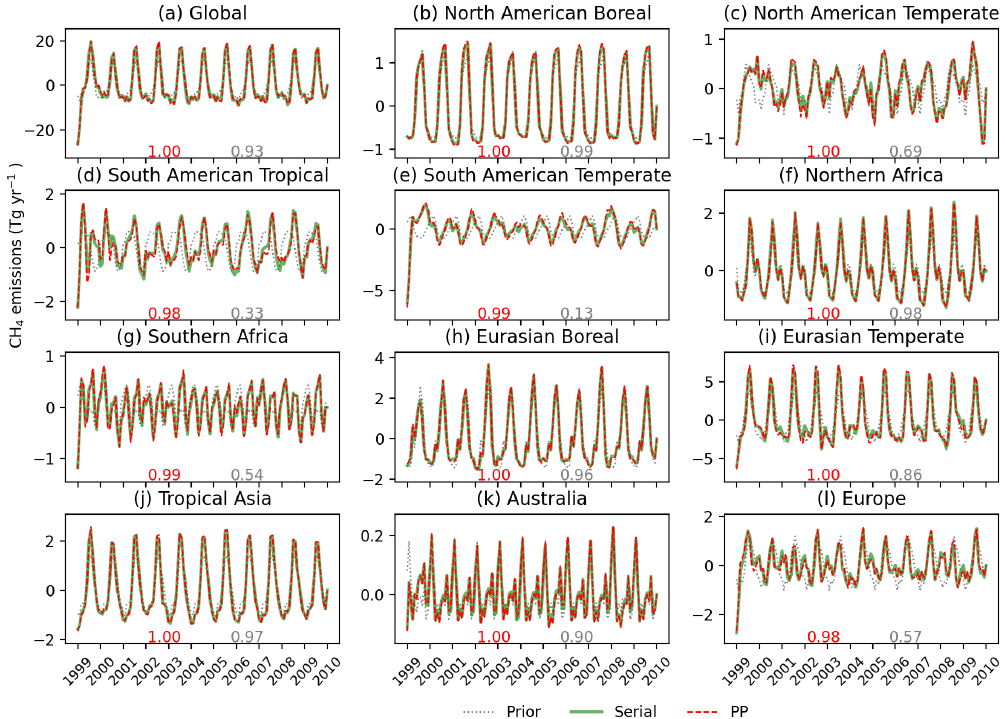
Figure 7. Intra-annual variation of the PP and serial emissions for the TRANSCOM regions. The correlation coefficients of the PP (red) and prior (gray) time series with the serial time series are given at the bottom of each panel. Table 1. Wall time comparison for the inversions performed in this study. Wall time projections for a hypothetical 35-year inversion are also given. Model runs Serial PP One year forward or adjoint run